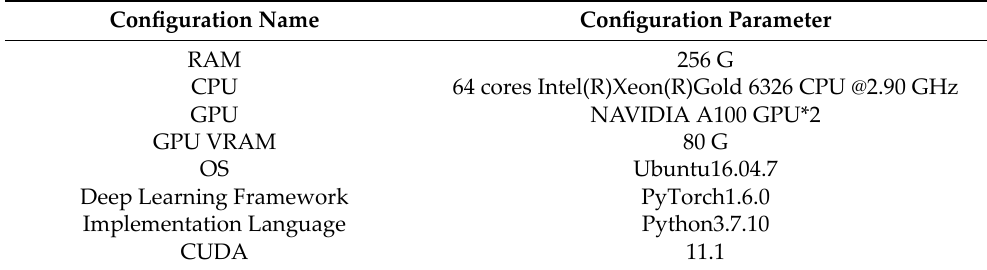
Table 4. Environment